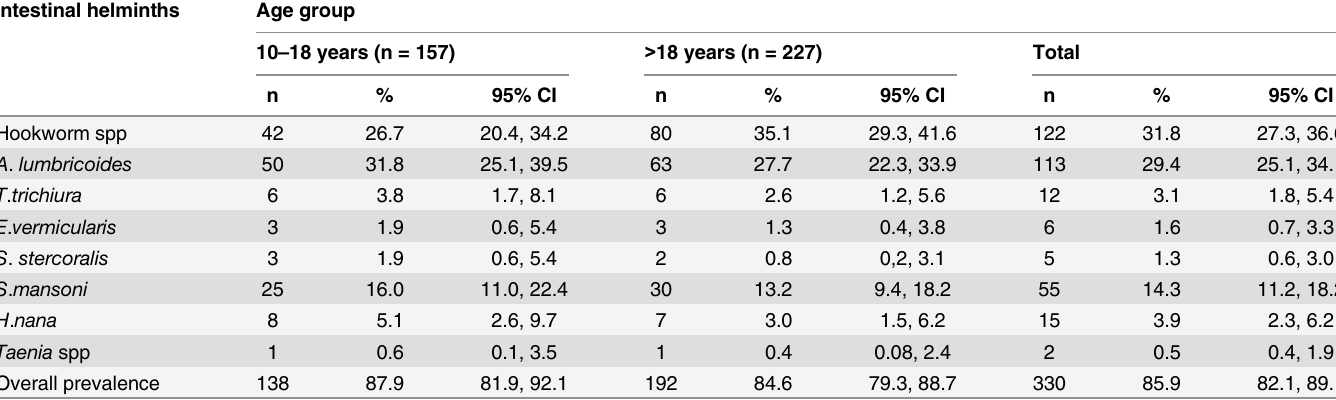
Table 2. Prevalence of STH and S . mansoni in students in Ethiopian Orthodox Church. Intestinal helminths